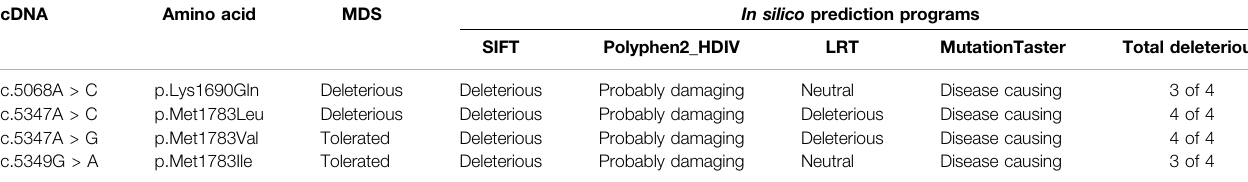
TABLE 3 | Prediction of deleterious variants for the unclassi fi ed variants in BRCA1 BRCT repeats. cDNA Amino